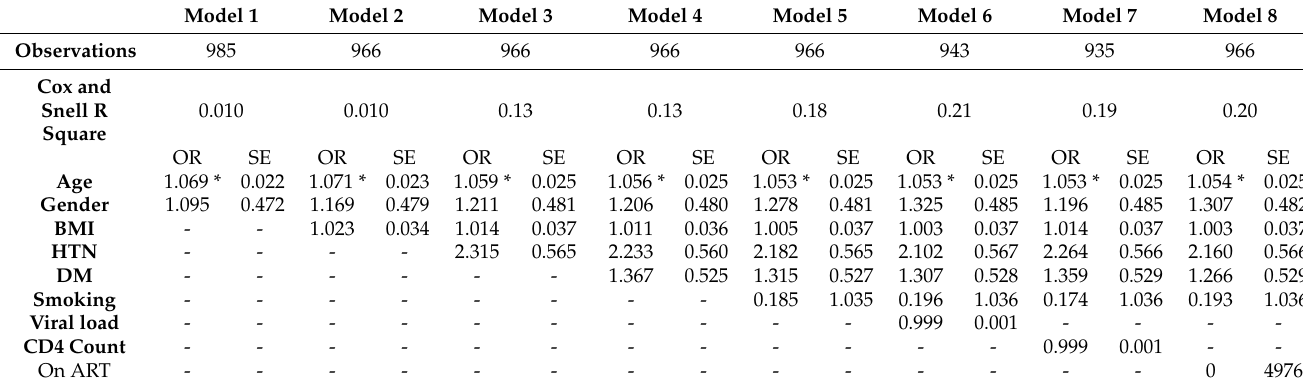
Table 2. Multivariate logistic models to identify possible predictors of